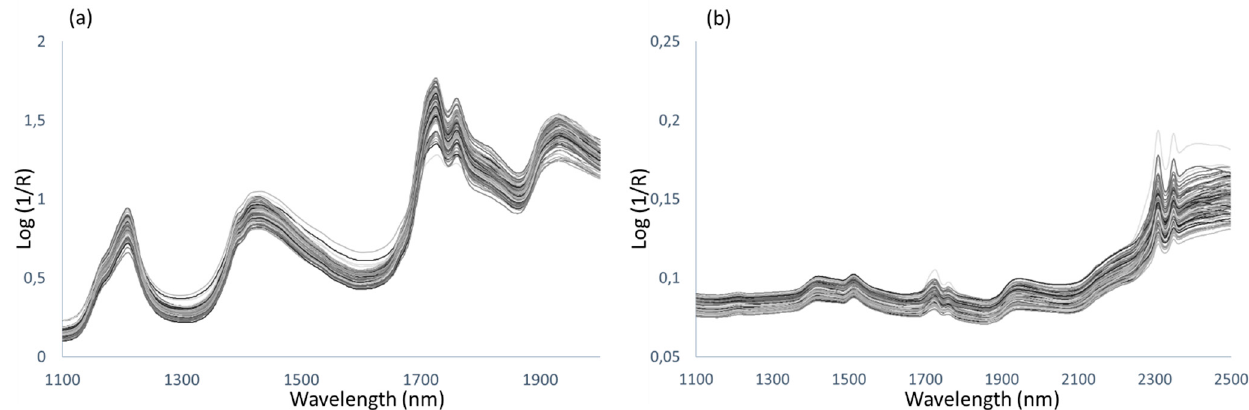
Figure 4. NIR spectra: ( a ) intact samples registered using fiber optic probe and ( b ) extracted samples registered using cam-lock capsules.